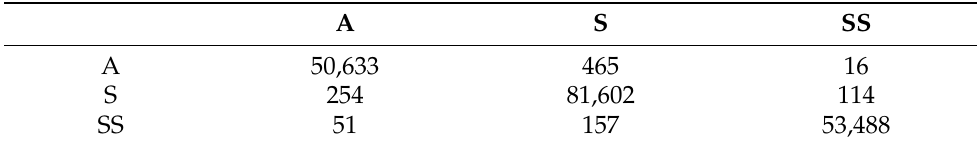
Table 10. Predictive results of the Random Forest model.